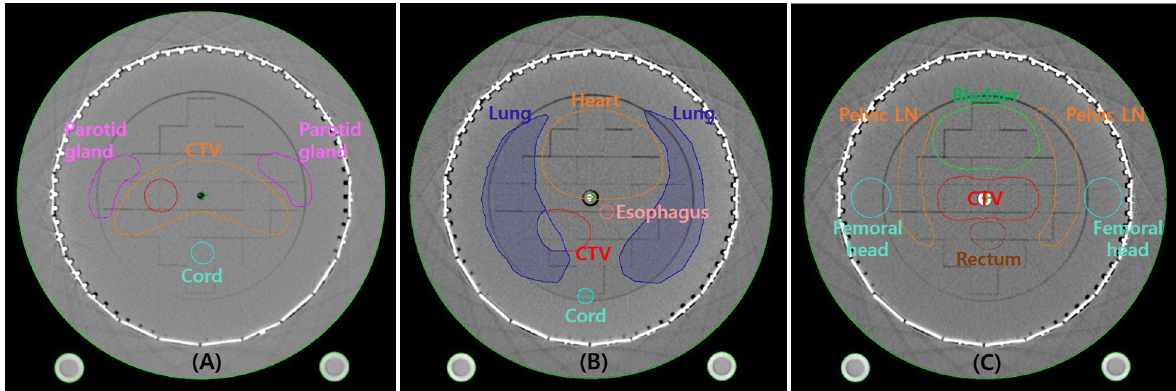
Fig 1. Contours of tumor target and OARs delineated on the ArcCHECK phantom. (A) head-neck plan, (B) lung plan, (C) prostate plan.